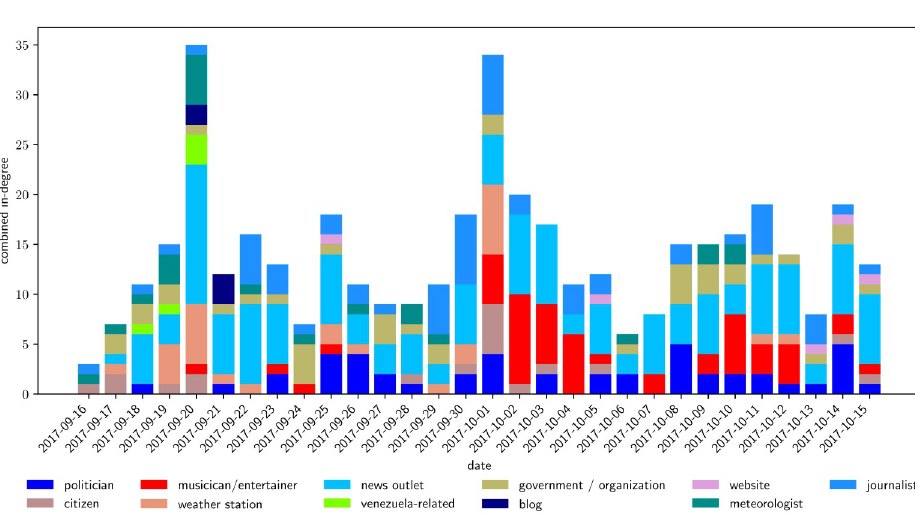
Fig 11. Stacked bar chart time-series showing the daily in-degrees of nodes in the top-fifty by in-degree of the aggregate network. The nodes are consolidated by manually determined type, shown in the legend. Of these nodes, the news outlets are the most consistently prominent, although politicians and journalists are fairly consistently present in the network as well. We find a spike in activity from musicians starting on October first, and decaying away by the sixth. Musician activity comes back for an interval of four days starting on October 9th, but this is all due to one single account, Residente. This can be seen in Figure S1 Fig, where we show the same timeseries separated by individual